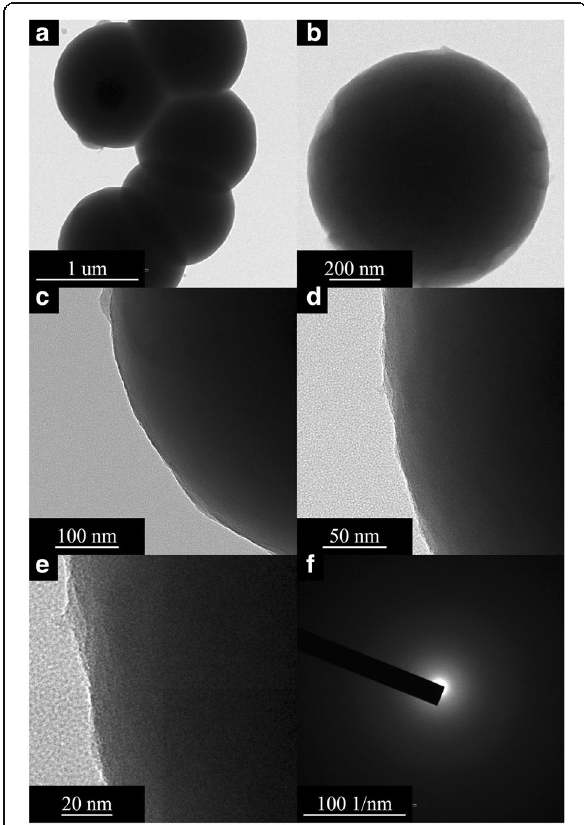
Fig. 9 FE-TEM morphology of cellulose-amino POSS hybrid composite (a-e) PVA/THPC (f) SAED